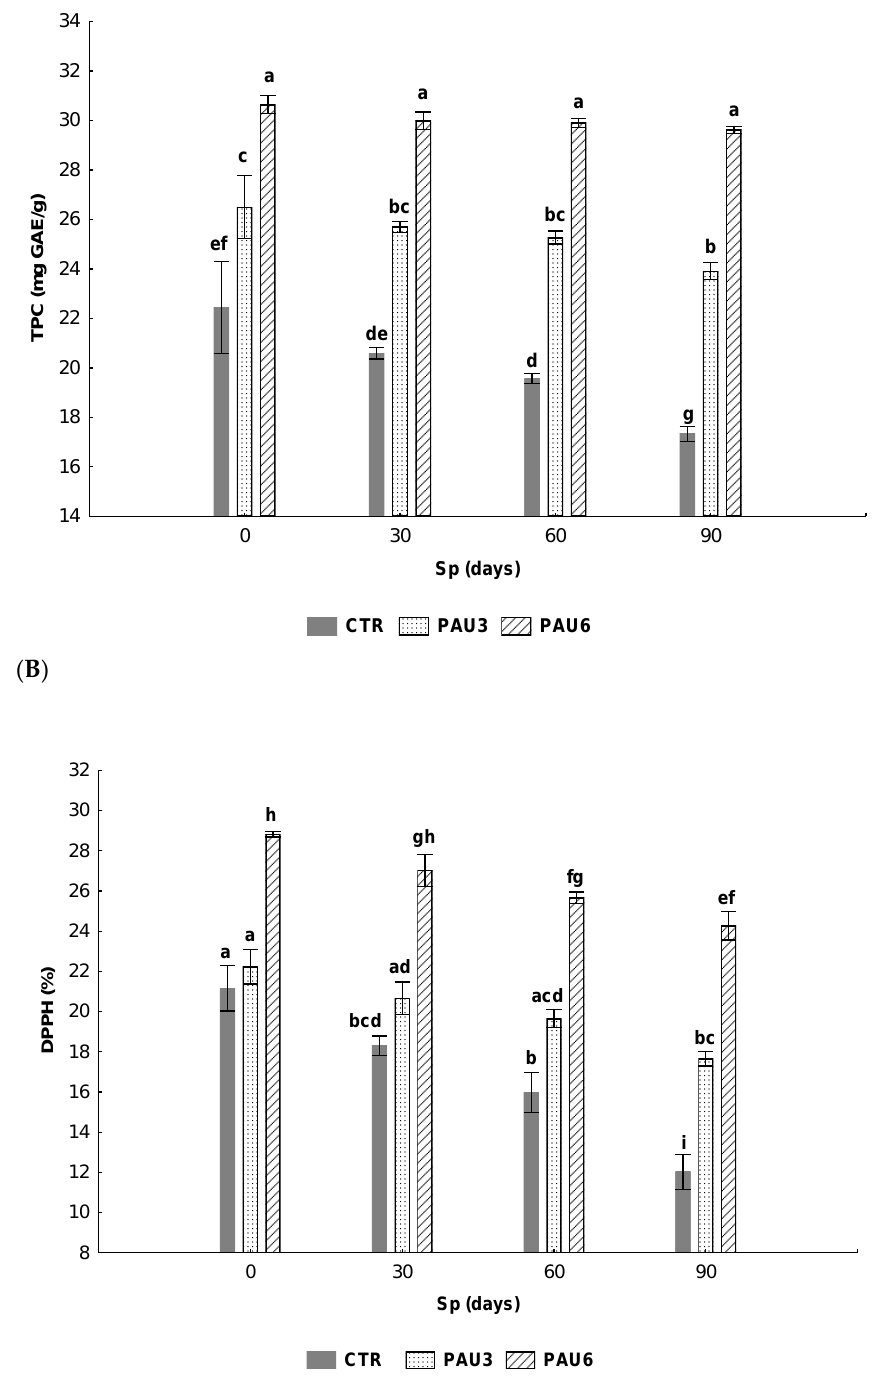
Figure 1. Effect of A. unedo fruits extracts in the total phenolics content (TPC) ( A ) and DPPH radical scavenging activity ( B ) of limpets pâté samples (CTR—with synthetic additive; PAU3—with 3% of A. unedo fruits extract; PAU6—with 6% of A. unedo fruits extract) stored at refrigerated temperature for 90 days. Bars with different letters represent significant differences ( p -value < 0.05). Error lines represent the standard deviation.